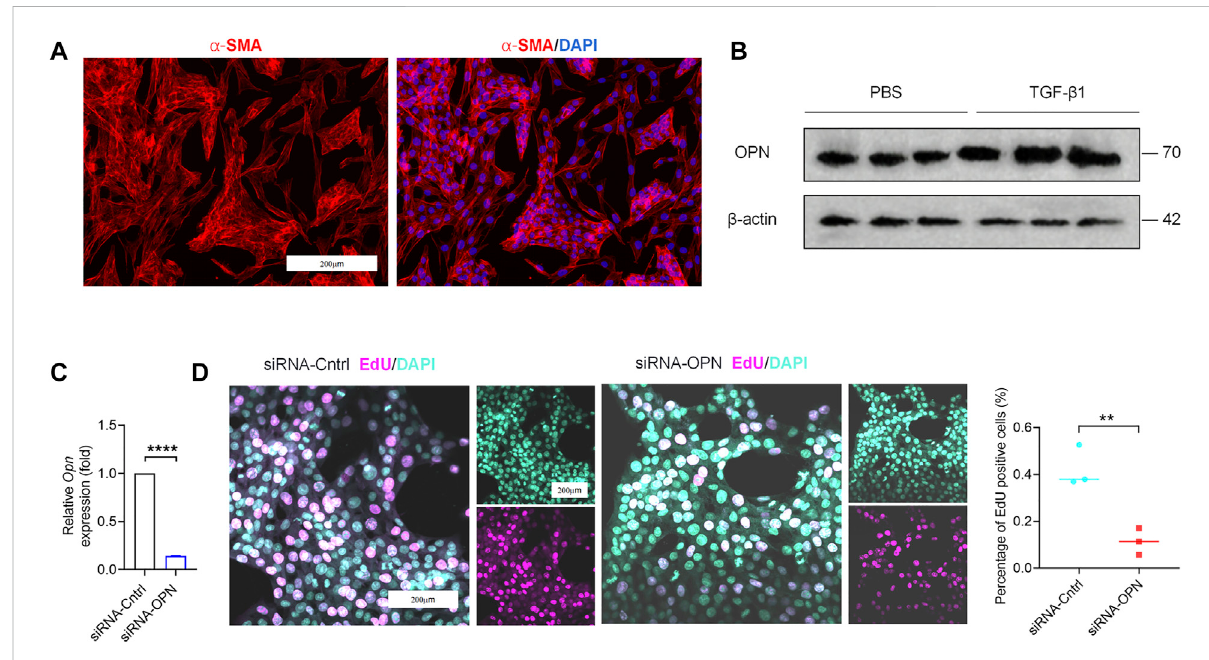
FIGURE 2 Accumulation of OPN activated primary HSCs. (A) Primary HSCs were isolated from wild-type (WT) mice. Images of IF staining for α − SMA (red) and DAPI (blue) of HSCs. Scale bar: 200 μ m. (B) OPN expression at protein level by western blot analysis. (C) qPCR analysis of OPN in primary HSCs after transfection with siRNA. (D) Proliferated cells detected by staining of EdU (left panel). The percentages of EdU-positive cells were quanti fi ed (right panel). Scale bar: 200 μ m. Data are expressed as the mean ± SD. (C,D) unpaired t – test. P < 0.01 **, p < 0.0001